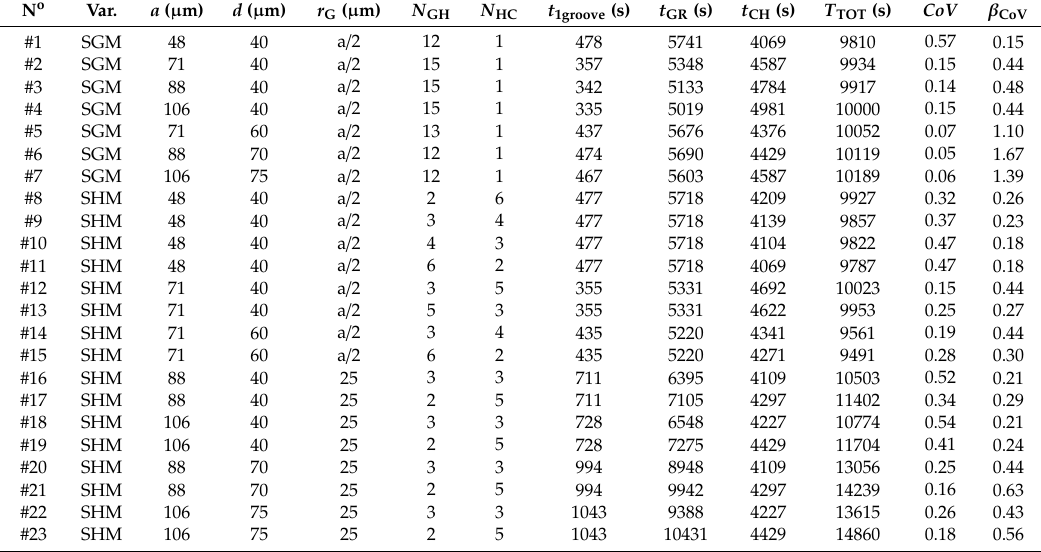
Geometrical definition of BGM configurations and simulated mixing